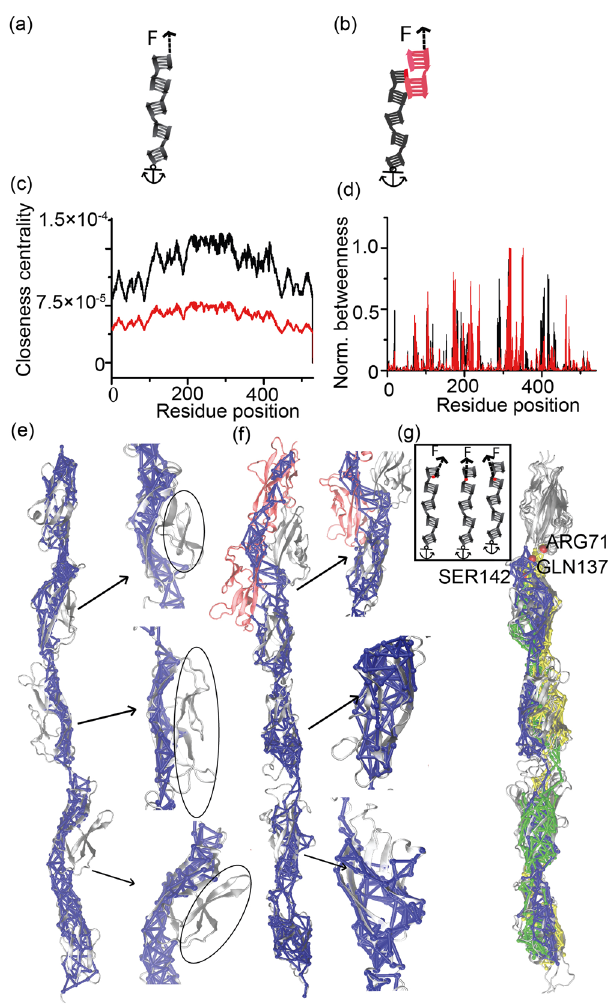
Fig. 3 Dynamic network structures of Cdh23 under tension in HAP and PAP modes. a Schematic representation of HAP in SMD. Black blocks represent the domains of Cdh23 EC1-5, where the C-terminal is anchored, and the N-terminal is pulled with a spring. b Schematic representation of PAP in SMD, depicting Cdh23 EC1-5 in black and Pcdh15 EC1-2 in red. Arrows guide the direction of the force. c Closeness centrality obtained for all the residues of Cdh23 EC1-5 in HAP (black) and PAP (red) con fi gurations have been plotted. Residues register a higher closeness centrality value in HAP compared to PAP. d Normalized betweenness centrality obtained for all the residues of Cdh23 EC1-5 in HAP (black) and PAP (red) shows higher betweenness values in PAP than HAP for most of the residues. e All the sub-optimal force-propagation paths (blue) from N-termini of Cdh23 EC1-5 to C-termini for HAP obtained from a dynamic network analysis of SMD pulling trajectory are overlaid on the ribbon structure of Cdh23 EC1-5 (gray). Here, solid blue tubes denote edges, and blue spheres denote nodes. Arrows guide the zoomed regions of respective EC2, EC3, EC4 domains and the domain regions devoid of any suboptimal path of force propagation are marked with black oval lines. f Sub-optimal force- propagation paths for PAP overlaid on the ribbon diagram of complex Cdh23 (EC1-5) -Pcdh15 (EC1-2). Zoomed regions of EC2, EC3, and EC4 highlight the widely distributed sub-optimal paths in all the strands of domains, unlike suboptimal paths in HAP of Cdh23. g Inset shows schematics of three independent SMD simulations of Cdh23 EC1-5 pulling from residues R71, Q137, and S142 and anchoring C-termini of Cdh23 EC1-5. Suboptimal paths of force propagation are constructed for all three independent simulations. Suboptimal paths obtained from pulling using R71 (yellow), Q137 (blue), S142 (green) are overlaid on the cartoon representation of Cdh23 EC1-5